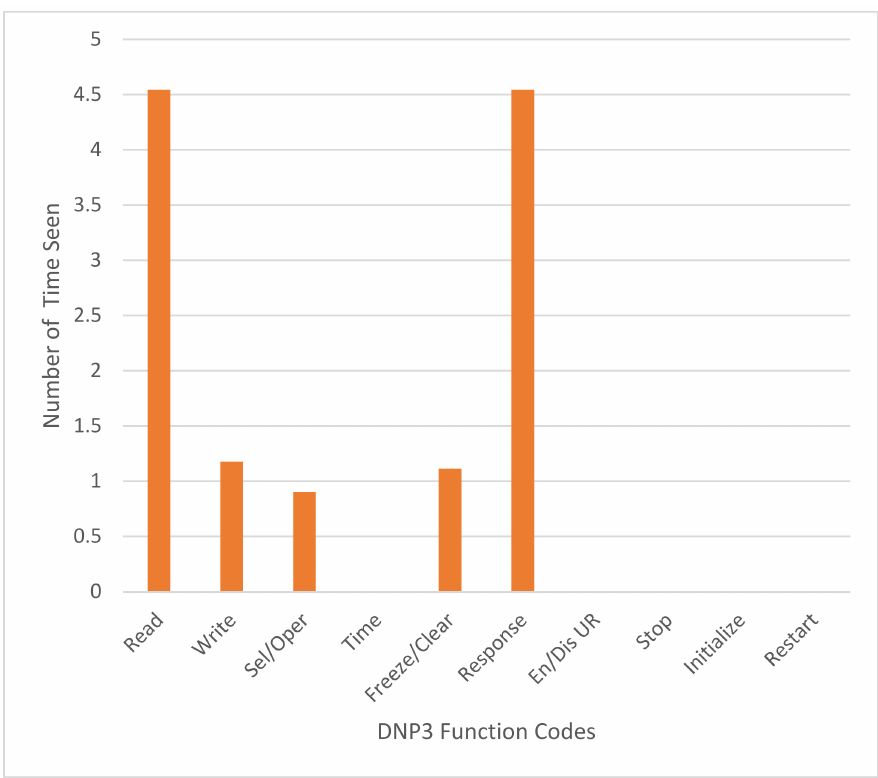
Figure 7. Function codes distributions of normal dataset.